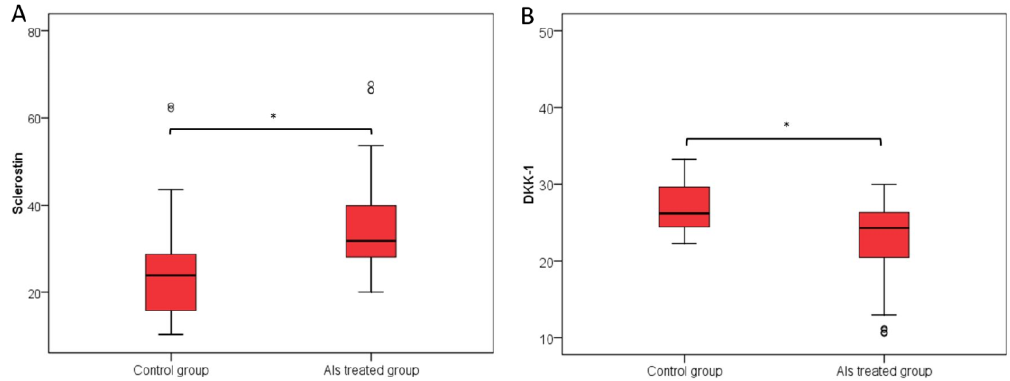
Figure 2. Circulating levels of sclerostin (Panel A ) and DKK1 (Panel B ) in AI-treated group and in the group of patients w/o AIs therapy. (Median, interquartile range). Significantly higher sclerostin values were in the AI-treated group of patients, with median 31.8 (IQR 28 to 40.2) compared to the group w/o AIs therapy, with median 24.1 (IQR 15.2 to 28.9) (Mann Whitney U test, p < 0.001) (Panel A ). DKK1 was significantly lower in the AI-treated group, with median 24.3 (IQR 20.4 to 26.4) compared to the median of patients w/o AIs therapy 26.02 (IQR 24.1 to 29.9) (Mann Whitney U test, p < 0.001) (Panel B ). * Mann Whitney U test.